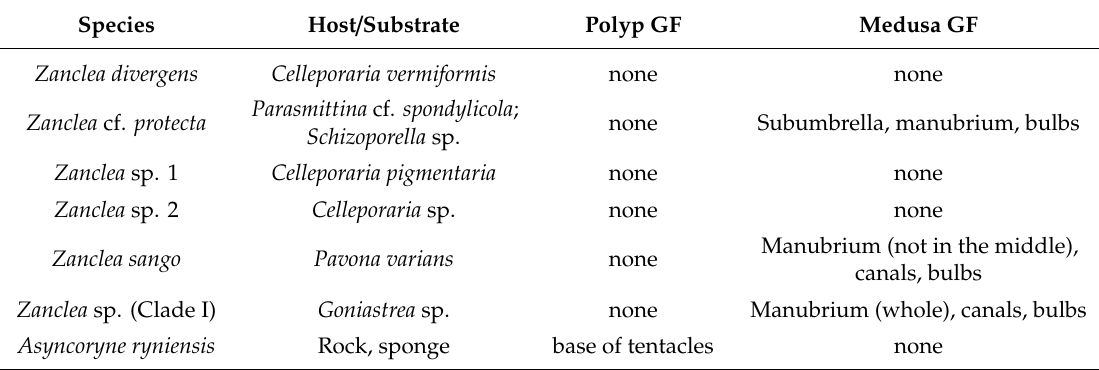
Table 3. Summary of green fluorescence (GF) patterns in polyps and medusae of Zanclea and Asyncoryne